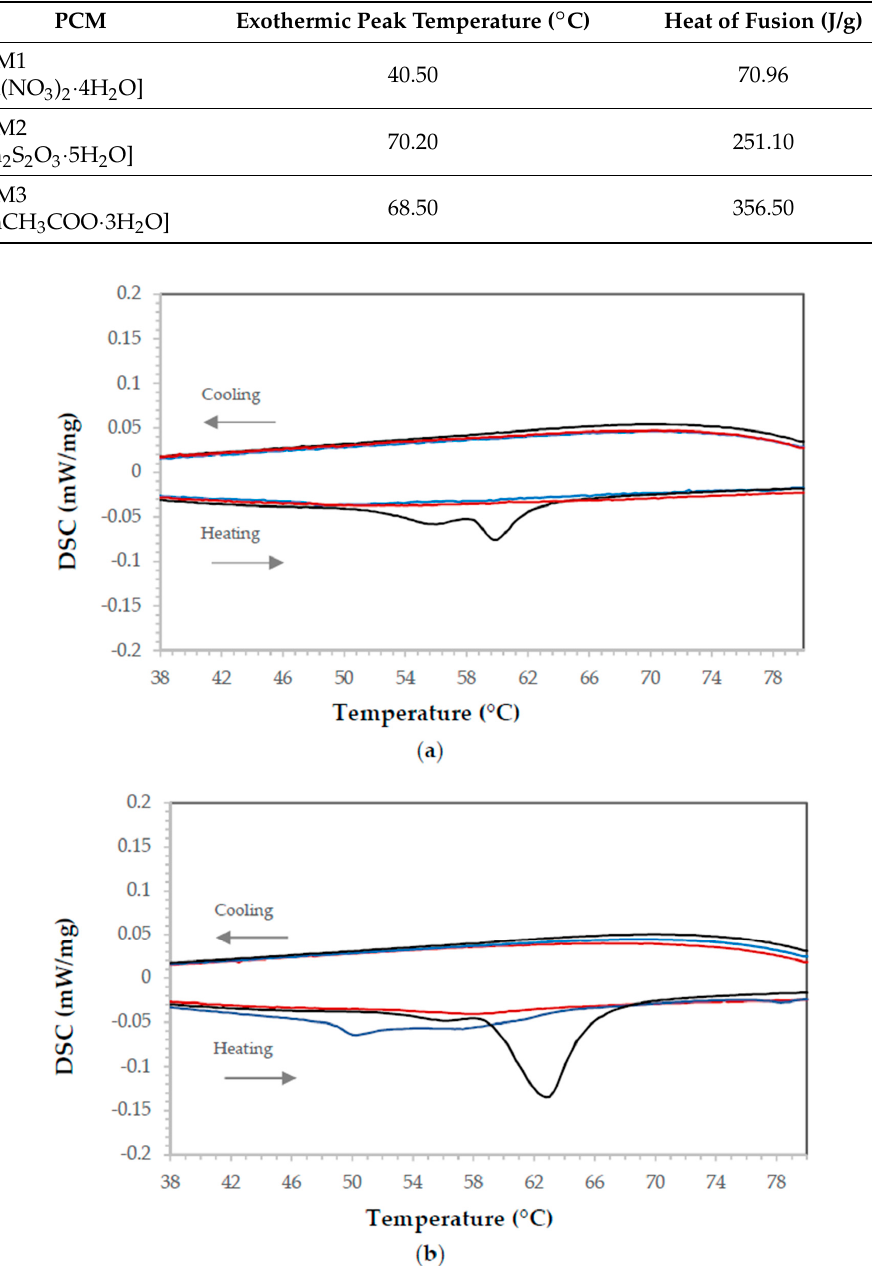
Figure 2. Endothermic peaks observed in Conductive Epoxy samples: ( a ) containing 3% PCM and ( b ) containing 10% PCM. PCM1, in red, corresponds to Zn(NO 3 ) 2 ·4H 2 O; PCM2, in blue, corresponds to Na 2 S 2 O 3 ·5H 2 O; and PCM3, in black, corresponds to NaCH 3 COO·3H 2 O.